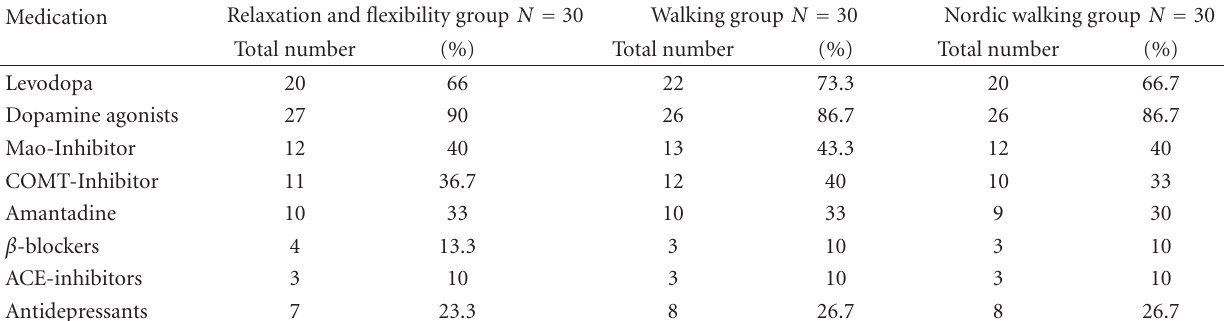
Table 2: Medication used by the patient groups.